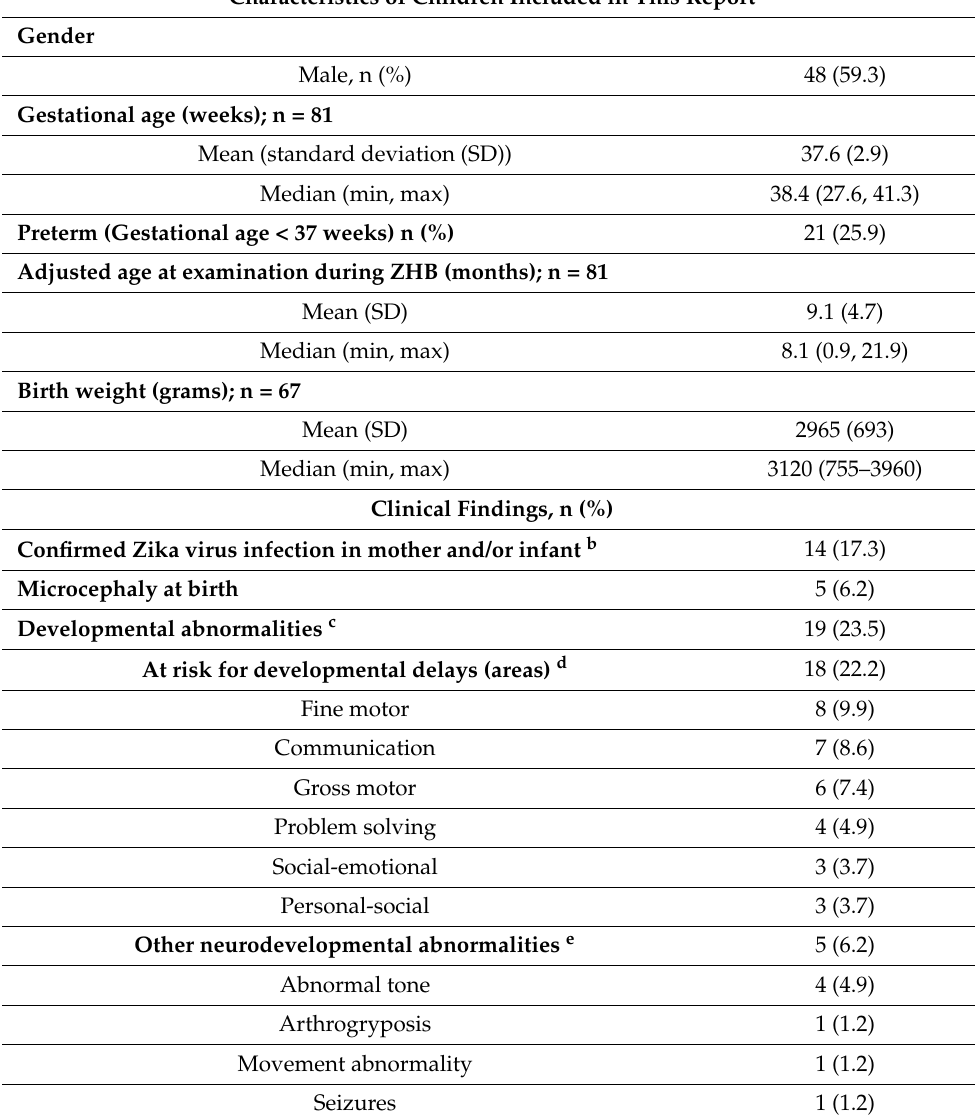
Table 2. Baseline demographic and clinical information a